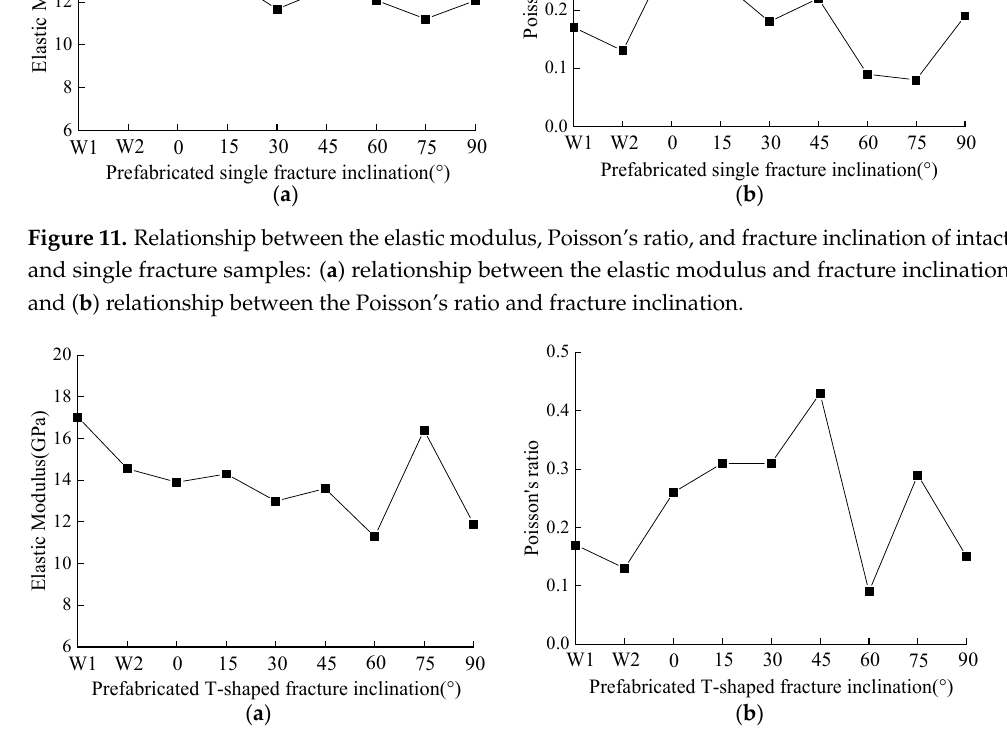
Figure 12. The relationship between the elastic modulus and Poisson’s ratio of the intact and T- shaped fracture samples: ( a ) relationship between the elastic modulus and fracture inclination and ( b ) relationship between the Poisson’s ratio and fracture inclination.